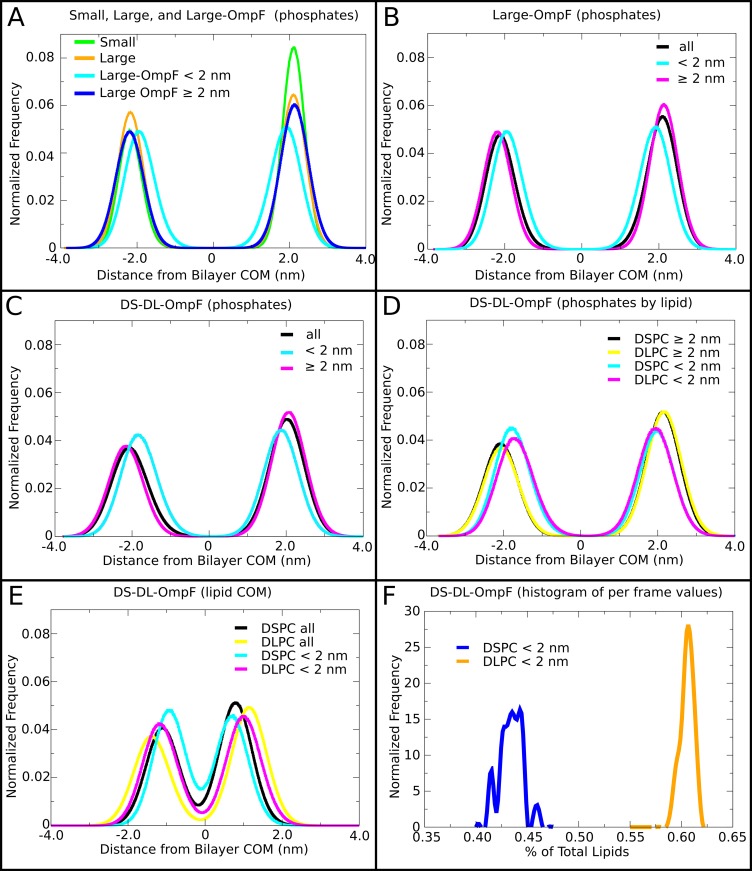
Vesicle membrane structure.The lipid phosphate particle positions are shown relative to the weighted radial center of the bilayer in Small, Large, DS-DL-OmpF and Large-OmpF. In (B), (C), (D) and (E) the lipids are separated based on whether they are close to OmpF (< 2nm), part of the bulk lipids (≥ 2nm), or considered altogether (all). In (C) and (D), the phosphate positions are shown for each lipid type in DS-DL-OmpF. In (E), the COM of the lipids is shown for each lipid type in DS-DL-OmpF. In (F), the per frame (spaced every 20 ns) percentage of lipids close to OmpF (< 2 nm) is shown separately for DLPC and DSPC. All the distributions, (A) to (F), have been calculated from frames originating from the second half of the trajectories.